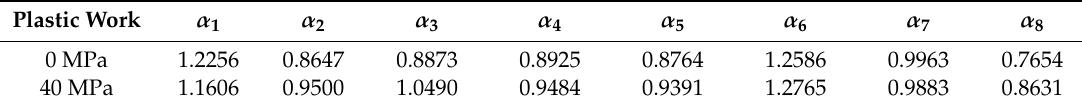
Table 11. Calibrated anisotropy coe ffi cients for the Yld2000-2D function of the niobium sheet under the associated flow rule ( m = 6).